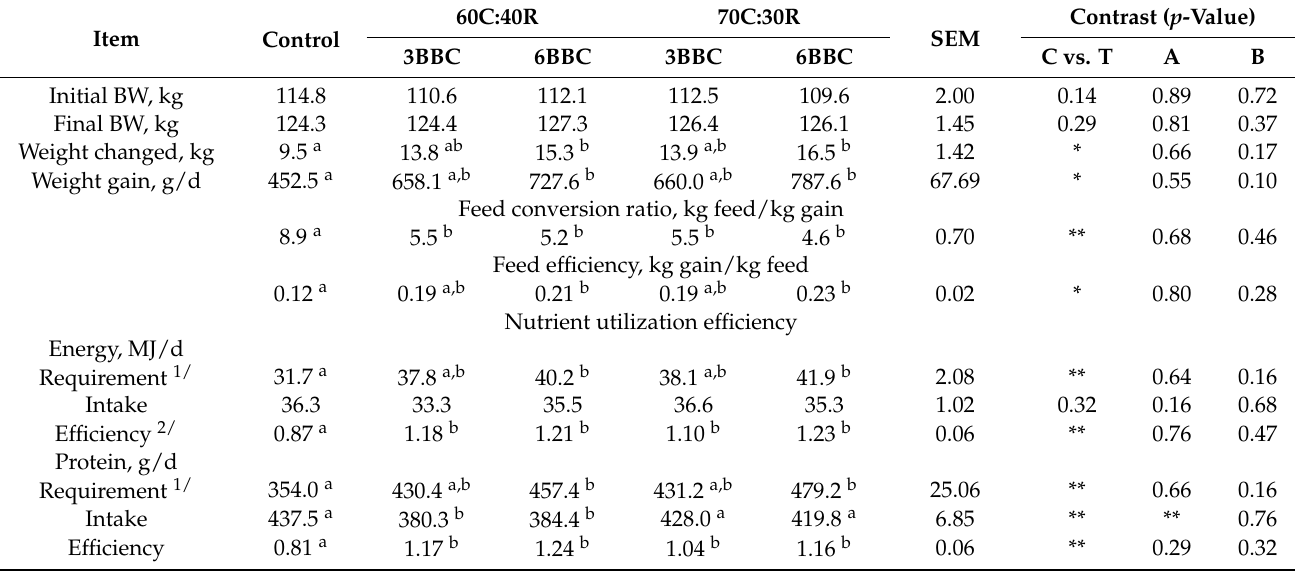
Table 6. Body weight change and feed conversion ratio and feed efficiency of beef cattle fed with different concentrate-to- roughage ratio diets and different levels of BBC